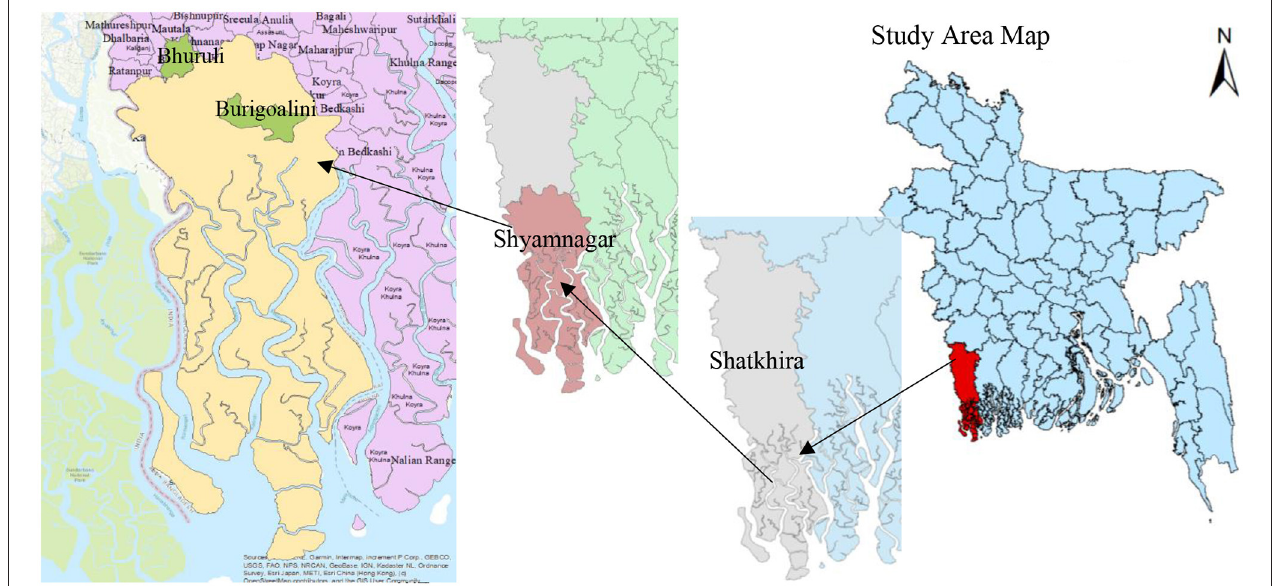
FIGURE 1 | Study area map.